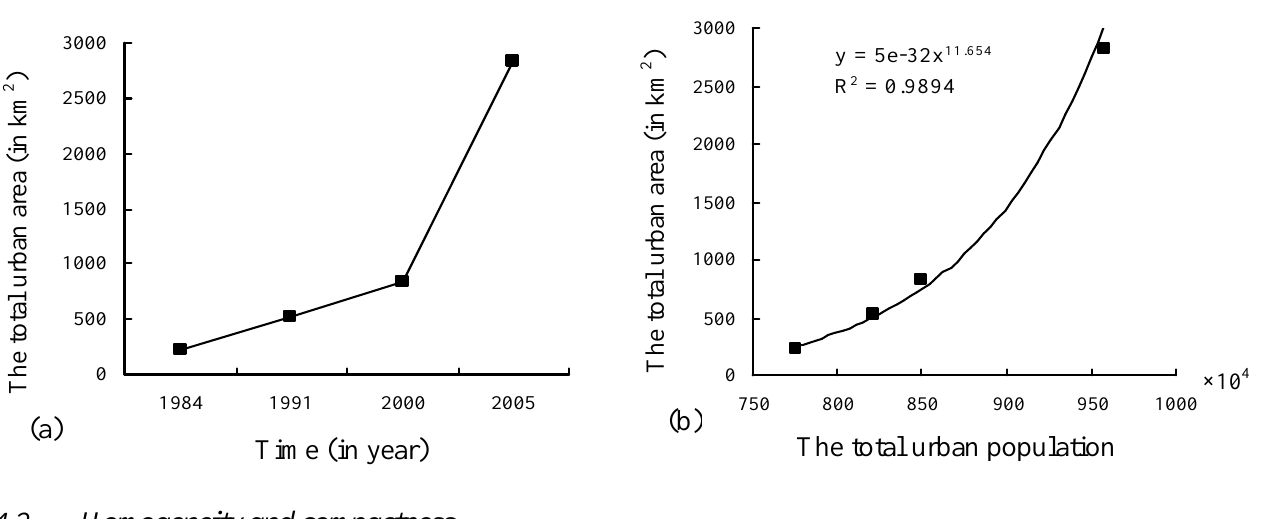
Figure 3. The total urban areas in different years and the relationship with the corresponding total urban